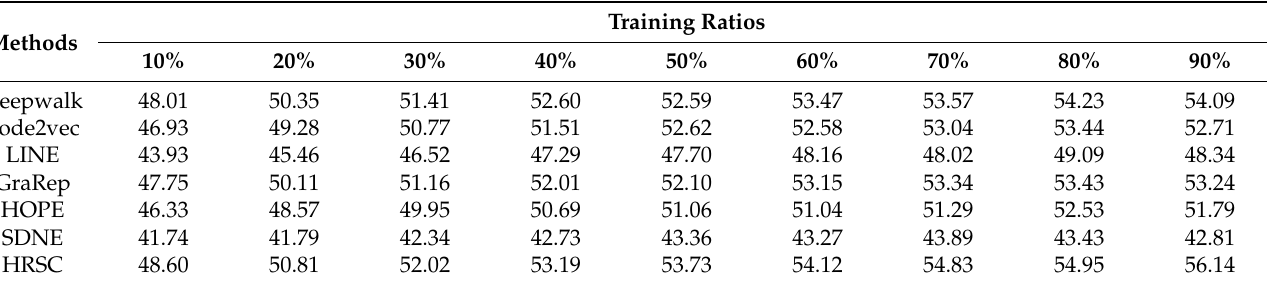
Table 3. Node classification accuracies on MovieLens